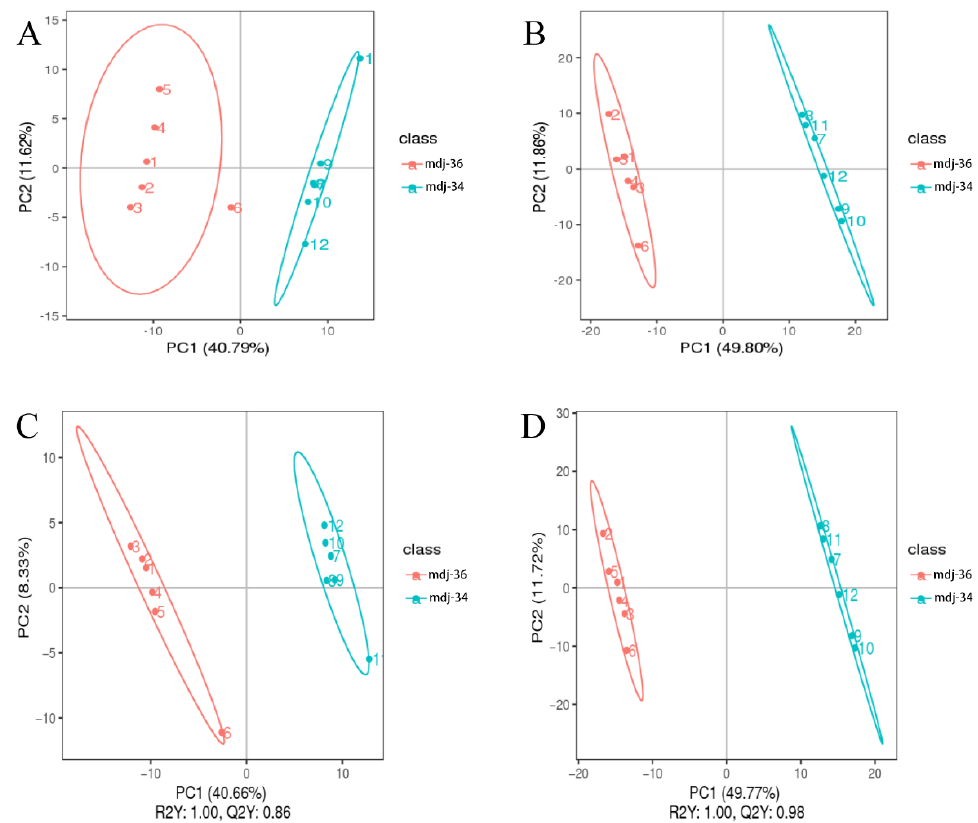
Figure 3. Principal components analysis (PCA) and partial least squares discriminant analysis (PLS-DA) of the metabolism differences between B. velezensis mdj-36 and mdj-34 growth media based on Liquid Chromatography Mass Spectrometry (LC-MS). ( A ) PCA analysis in the positive mode; ( B ) PCA analysis in the negative mode; ( C ) PLS-DA analysis in the positive mode; and ( D ) PLS-DA analysis in the negative mode.